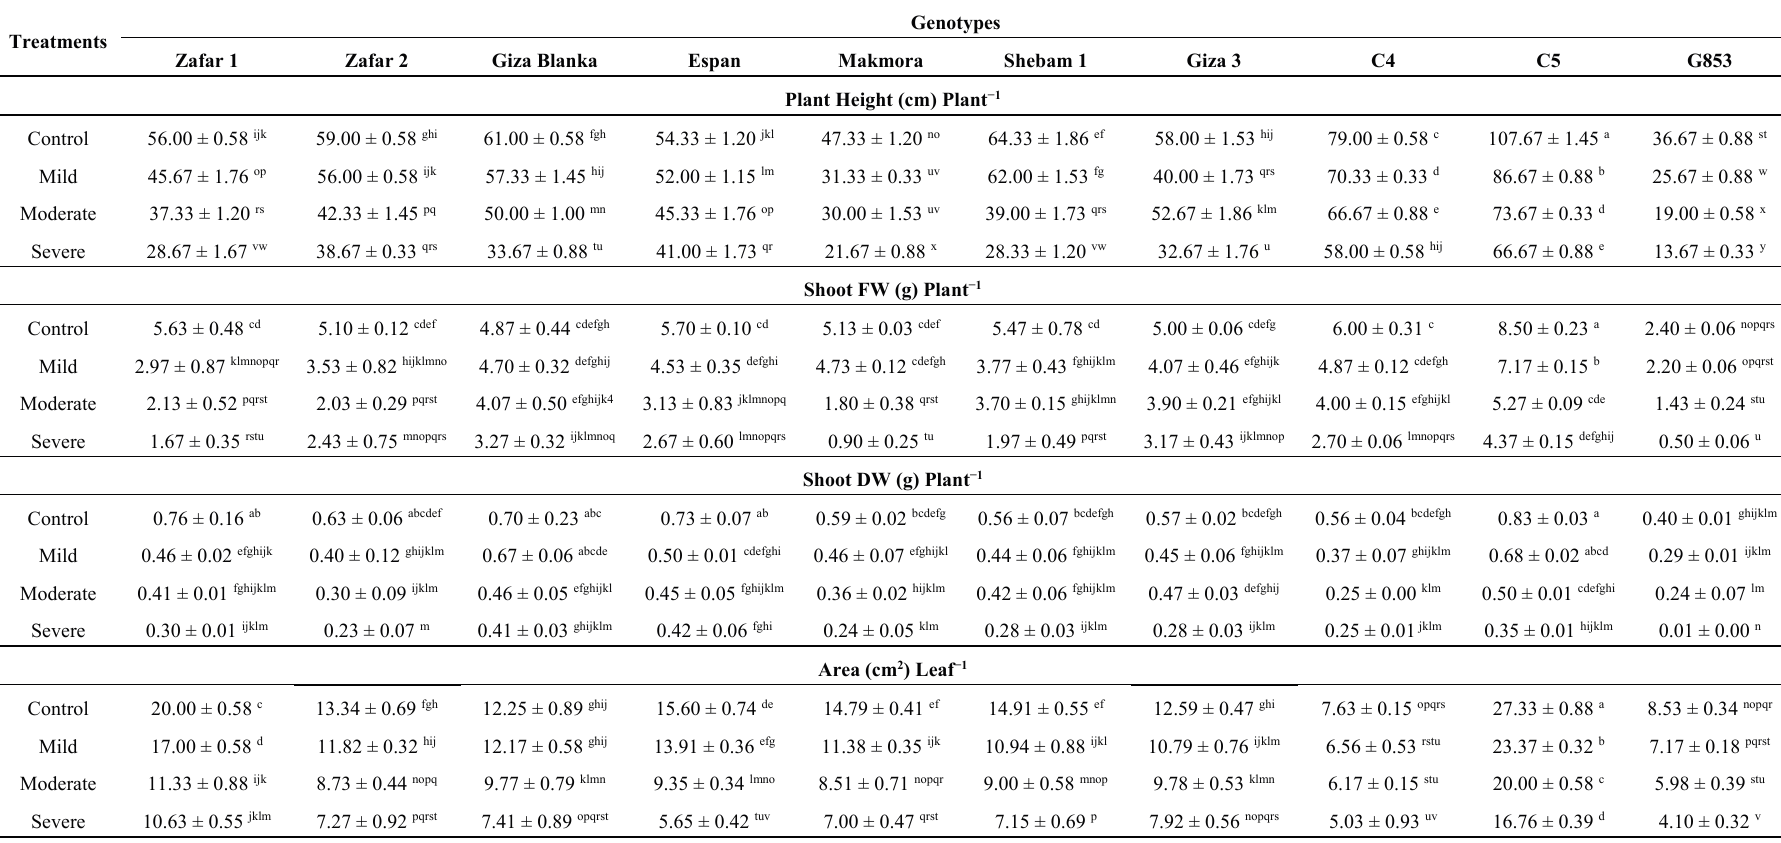
Table 1. Growth performance of faba bean genotypes under drought